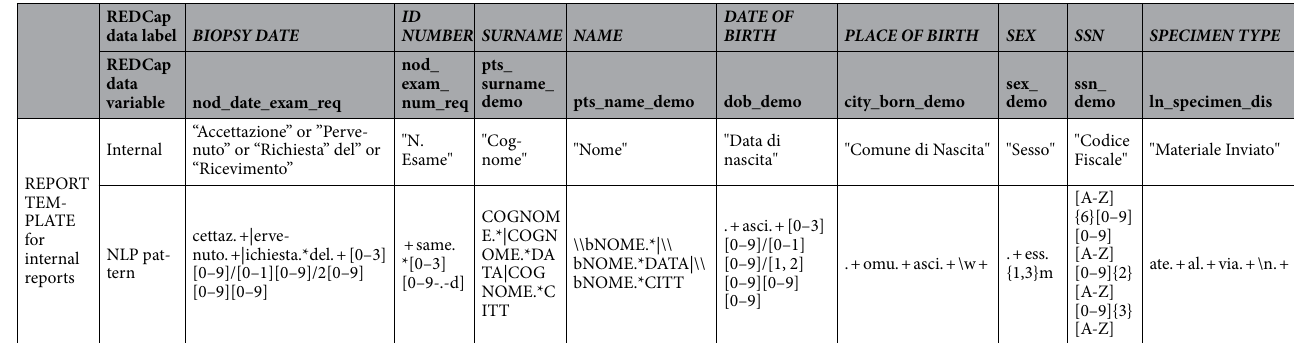
Table 4. Set of NLP regular expressions embedded into the header_function.py for the internal reports. NLP: Natural Language Processing; ID: Identification; NA, Not Available, SSN, Social Security